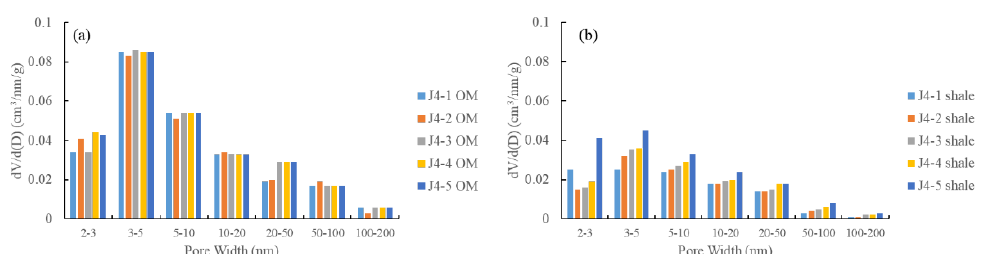
Figure 5. Pore volumes ( a )–( b ) distribution derived from low-pressure CO 2 adsorption isotherms for ( a ) OM and ( b ) bulk shale samples.